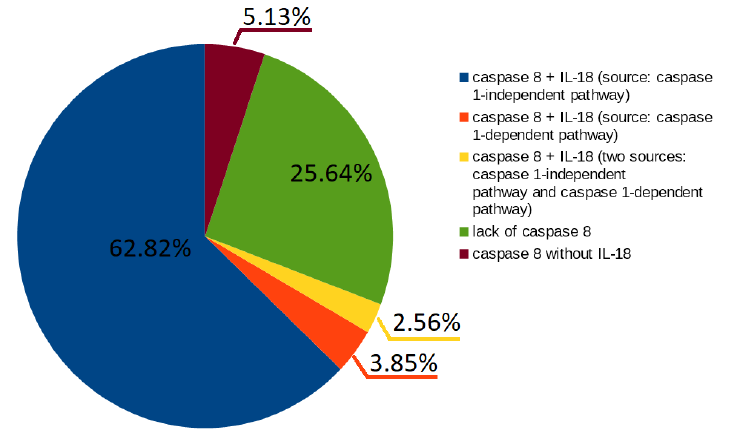
Figure 2. The diagram presents a count of t-invariants corresponding to subprocesses in which caspase 8 is